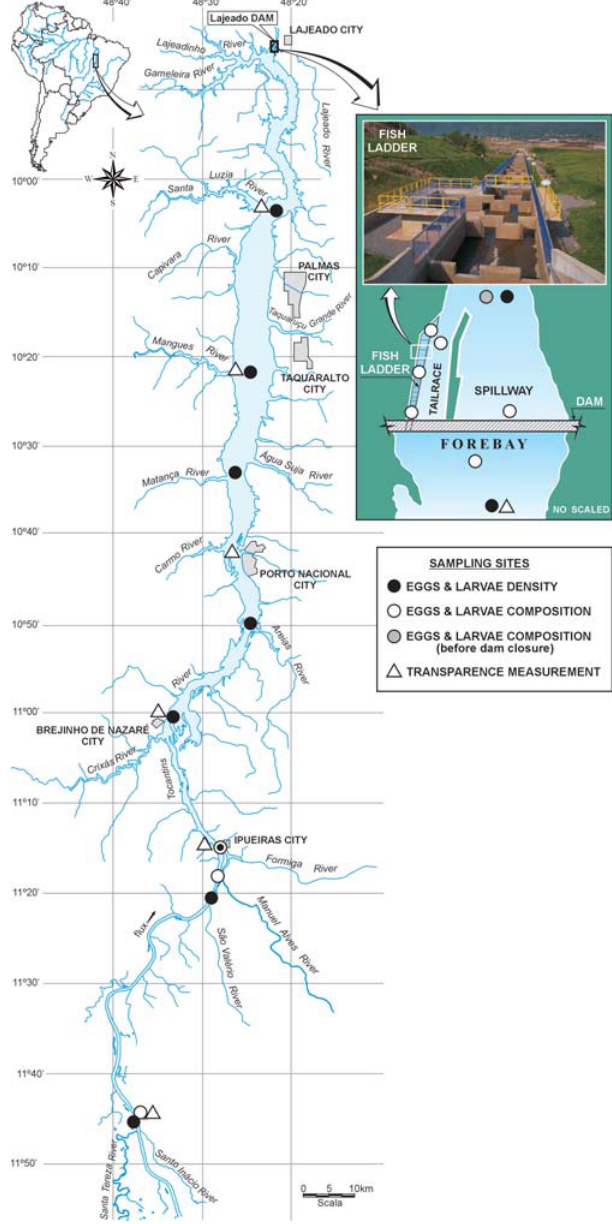
Fig. 1. Sampling sites in the Tocantins River and Lajeado Reservoir (detail: area close to the dam and the fish